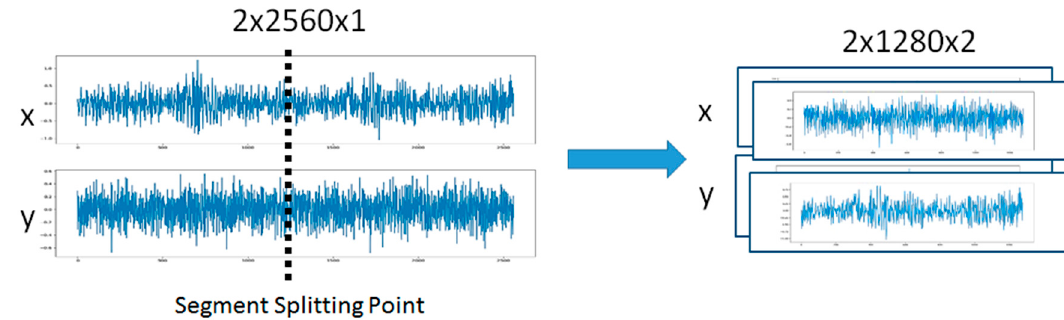
Figure 5. The time series of the 2 × 2560 × 1 shape (with 2 rows, 2560 columns, and 1 channel) is reshaped to be of the 2 × 1280 × 2 shape (with 2 rows, 1280 columns, and 2 channels).